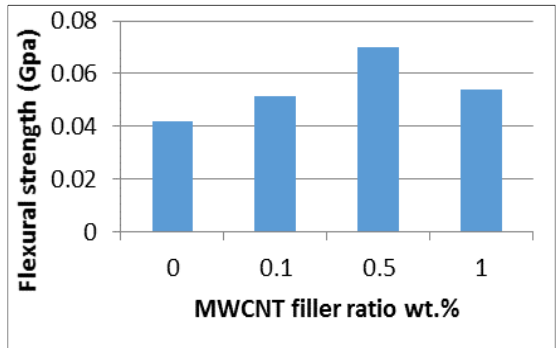
Fig.7. Flexural strength of MWCNT/epoxynano- composites in various loading